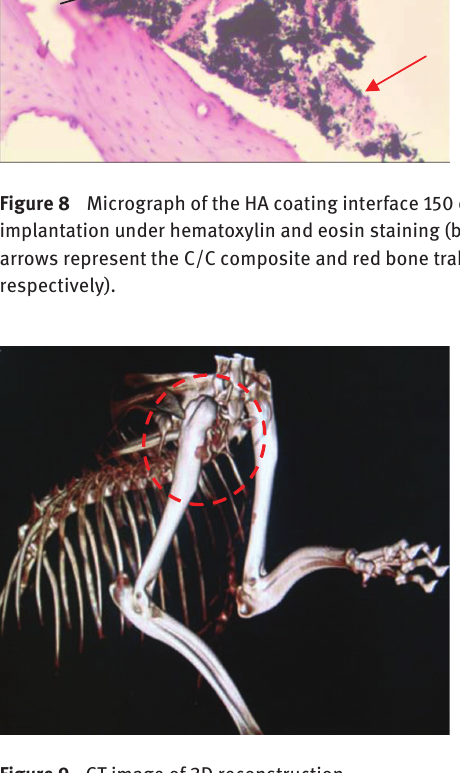
Figure 9 CT image of 3D